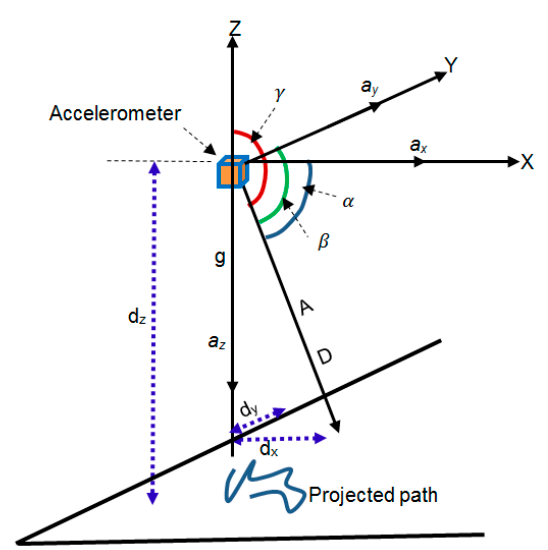
Figure 1. Tracing of the trajectory of the accelerometer on ground [25].